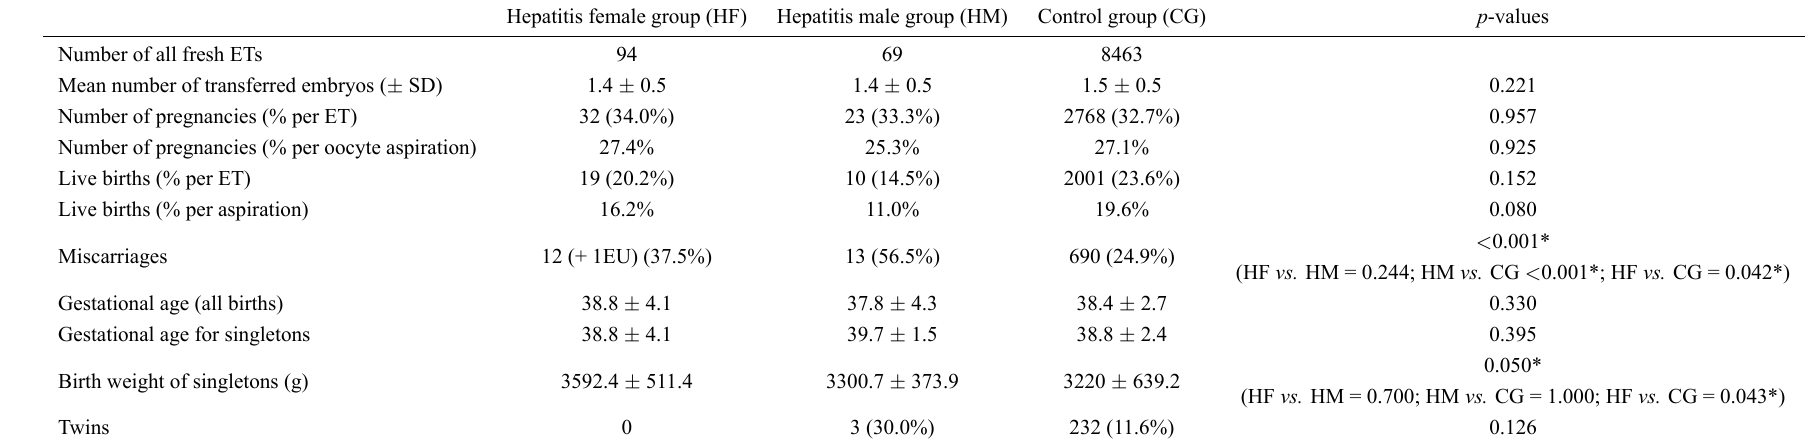
Table 3. Clinical outcome of IVF/ICSI cycles. Statistically significant differences are marked with an asterisk ( p value <